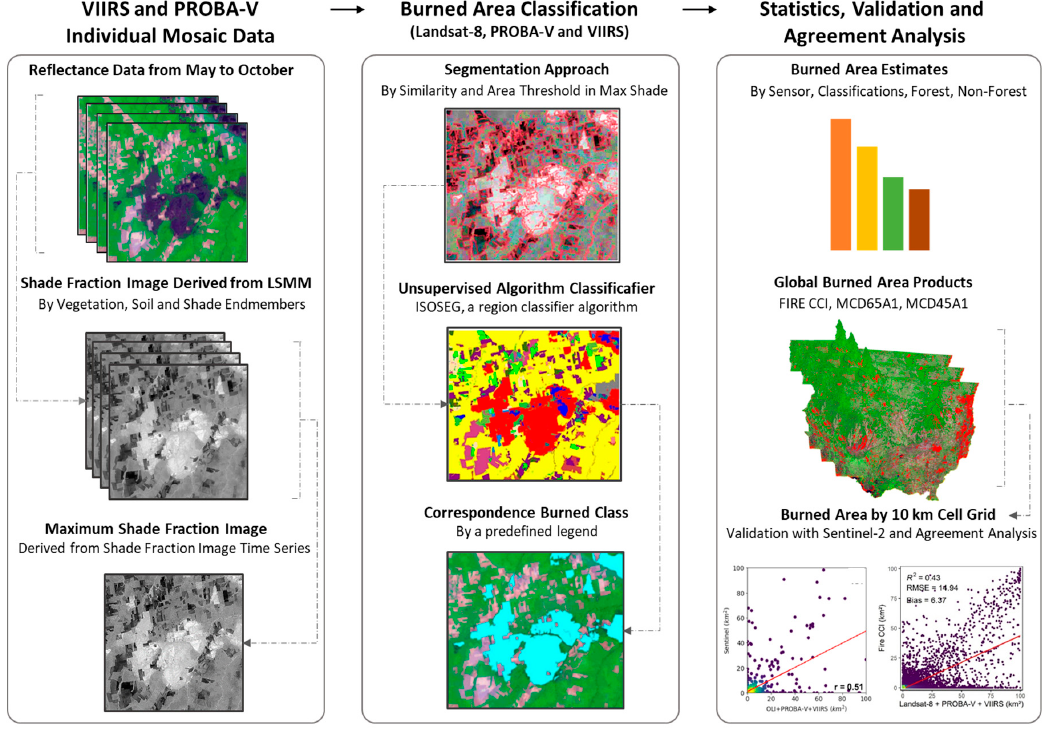
Figure 4. General methodological flowchart.